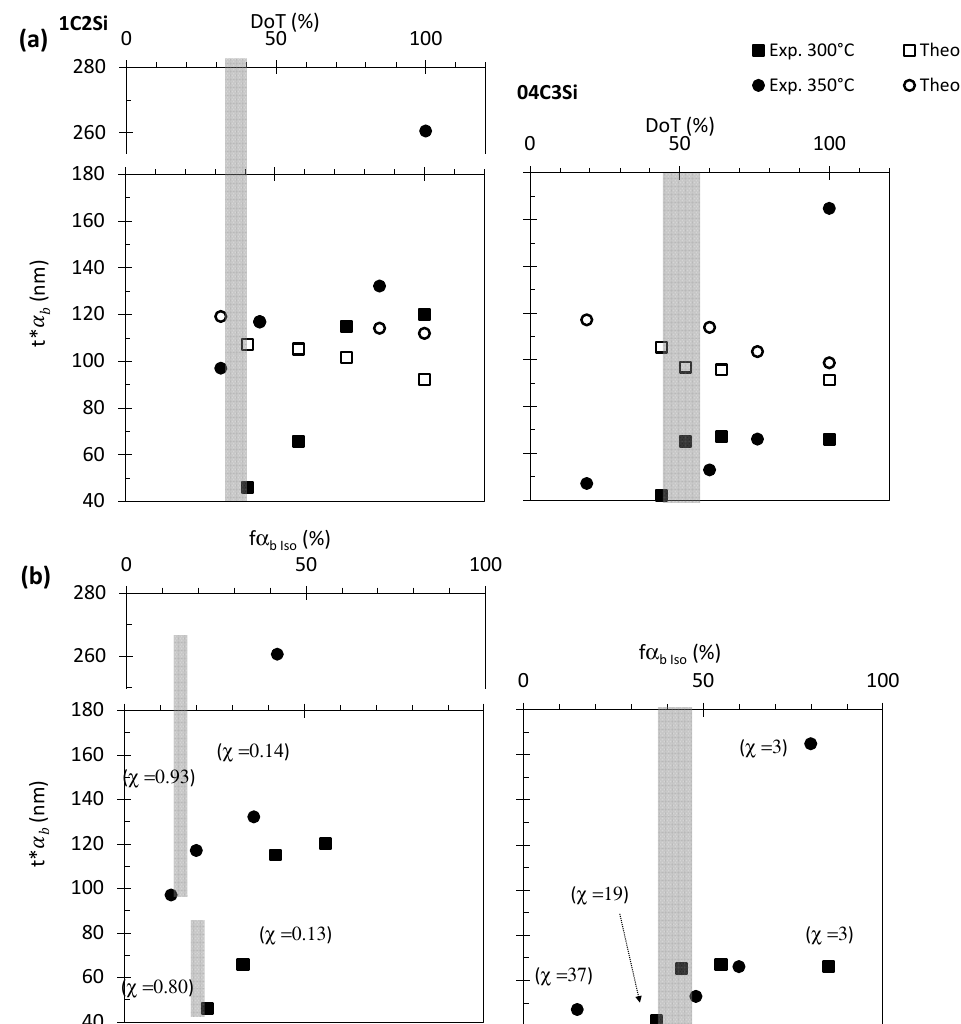
Figure 12. Bainitic ferrite plate thickness, t * α b , as a function of ( a ) the degree of transformation (DoT) and ( b ) fraction of bainitic ferrite, f α b , Iso . The shaded regions represent where the DRCL max is reached.